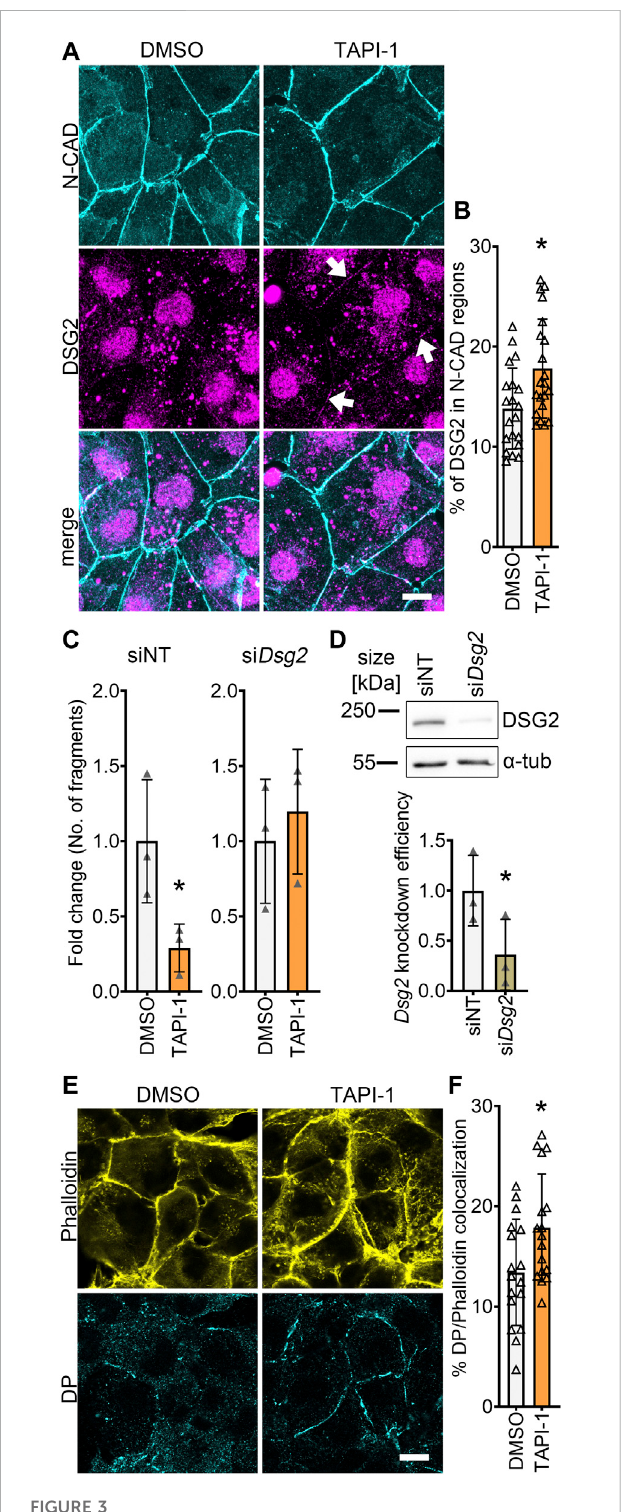
FIGURE 3 ADAM17 inhibition leads to enhanced localization of DSG2 and N-CADatthecellborders. (A) Maximumprojectionsofimmunostainings in HL-1 cardiomyocytes for N-CAD and DSG2 showing an increase of DSG2 (white arrows) at the cell borders after 90 min of TAPI-1 treatment. Z-scans spanning the whole cell volume, z-steps = 0.25 µm. Scale bar: 10 µm. (B) Quanti fi cation of colocalization of N-CAD and DSG2inHL-1 cardiomyocytes,* p ≤ 0.05, unpairedStudent ’ s t -test.Each datapointrepresentsoneimage, N =8biologicalreplicates. (C) Dispase- based dissociation assay in HL-1 cardiomyocytes after